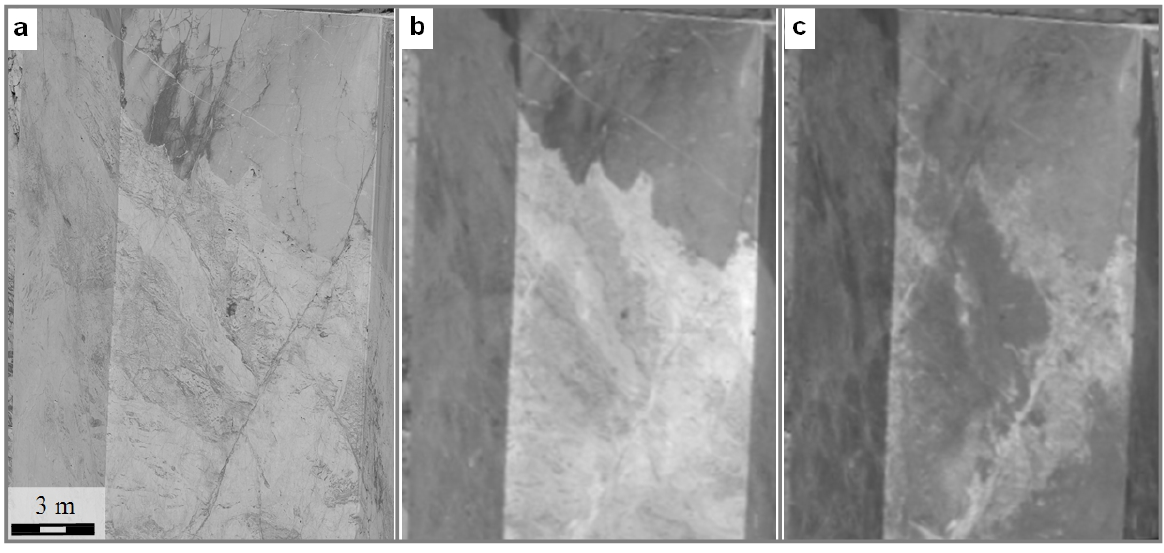
Figure 6. ( a ) Sample of the greyscale Nikon D200 and the corresponding area in image P-B1 ( b ) band 1: 1.336 µm and ( c ) band 158: 2.102 µm.